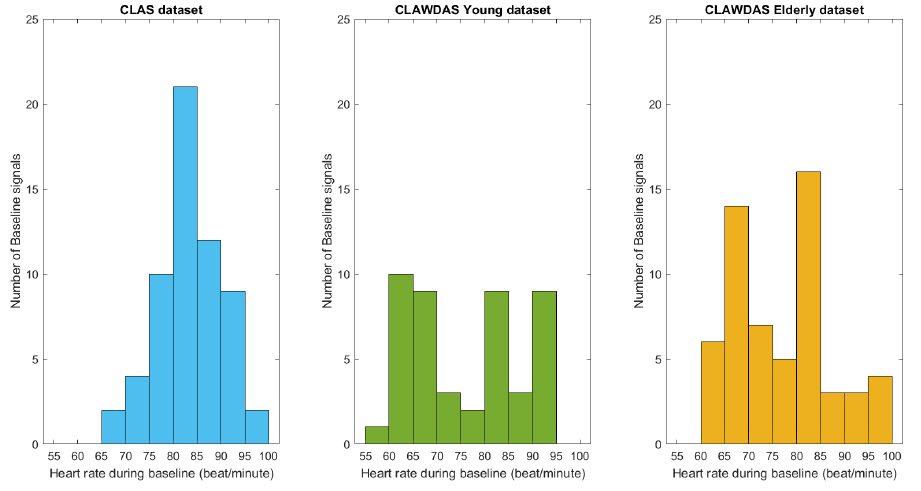
Figure 3. Distributions of the average heartbeat of the resting state PPG signals in CLAS ( left ), CLAWDAS Young ( middle ), and CLAWDAS Elderly ( right )